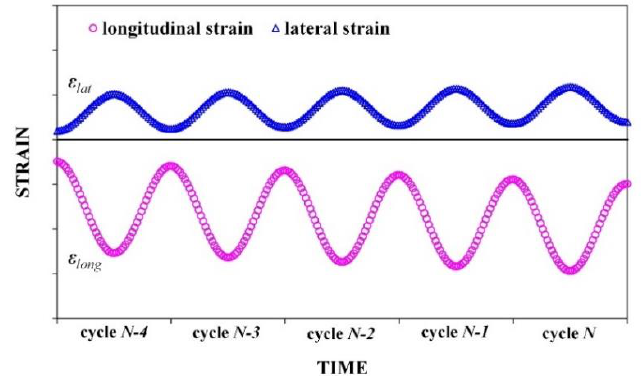
Figure 3. Longitudinal and lateral strain in the last five cycles obtained by OFBG sensors.